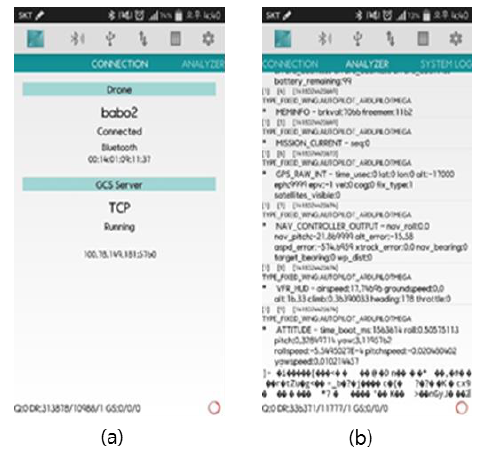
Figure 3. UAV telemetry module screen shots. (a) main, (b) Mavlink log